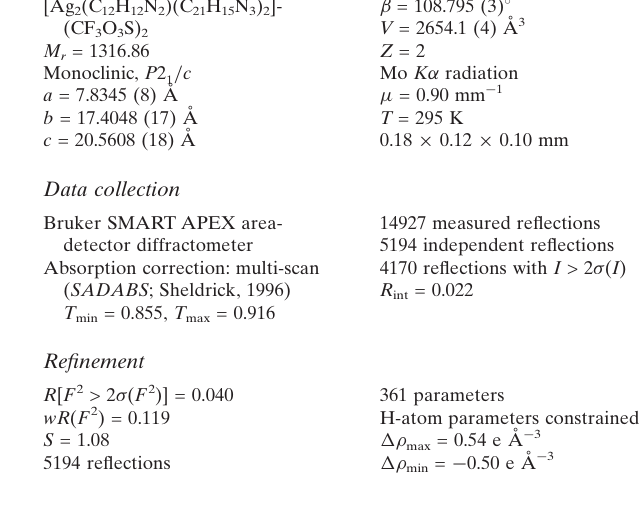
Experimental Crystal data